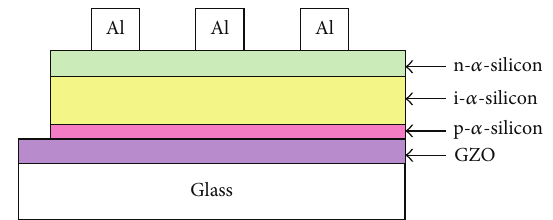
Figure 8: Structure of the superstrate p-i-n 𝛼 -Si:H thin-film solar